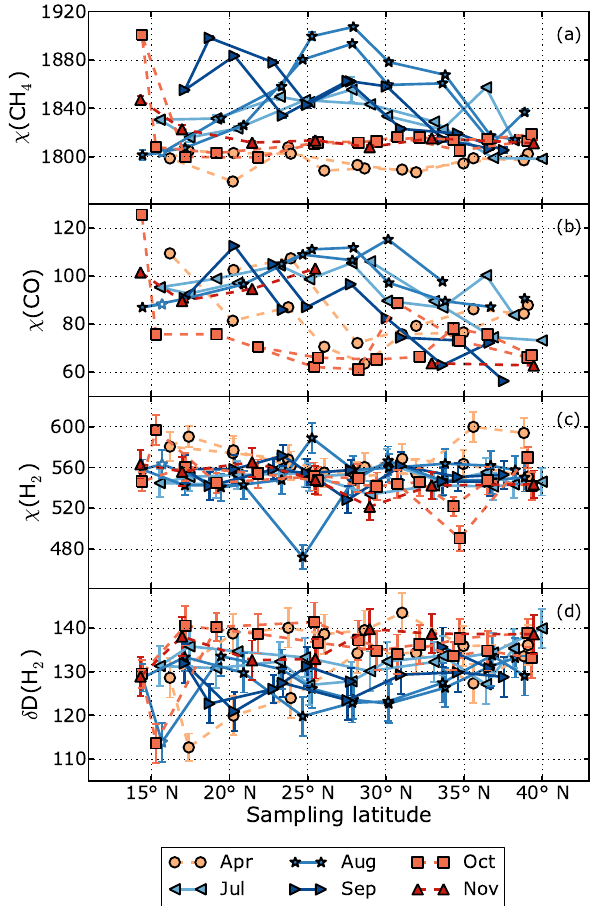
Fig. 7. χ (CH 4 ) (a) , χ( CO ) (b) , χ (H 2 ) (c) and δ D (d) for the sam- ples taken on flights to Chennai south of 40 ◦ N in the monsoon season (blue tones) and outside the monsoon season of 2008 (red tones). The open symbol (16 ◦ N) indicates a sample with a back trajectory originating outside of the monsoon system that was not taken into account in the